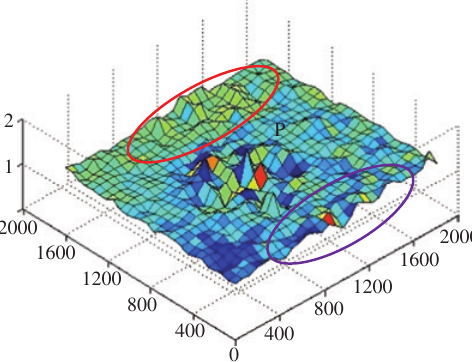
Figure 5 MatPIV 1.6.1 software-SURF result (processing of the first and 24th images after switching off the soldering iron).